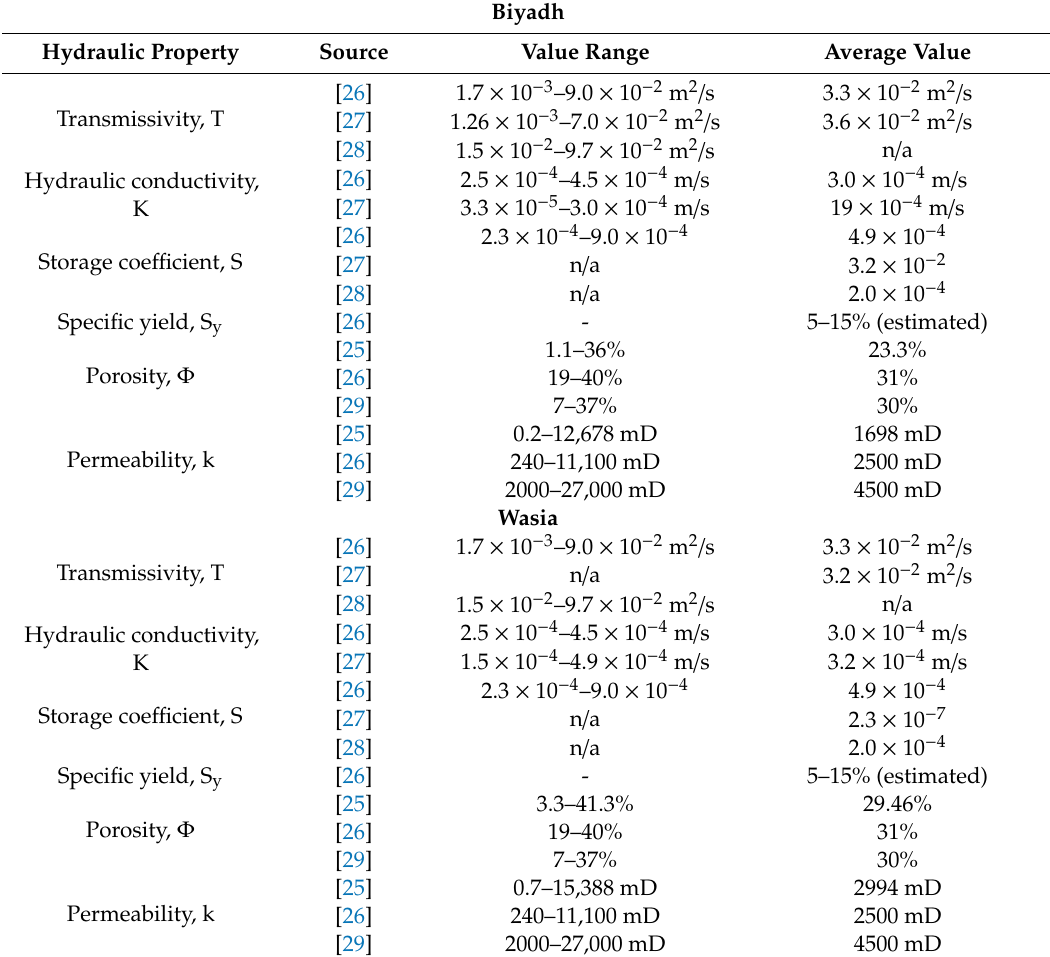
Table 1. Hydraulic properties of the Biyadh and Wasia aquifers (modified from [26]).